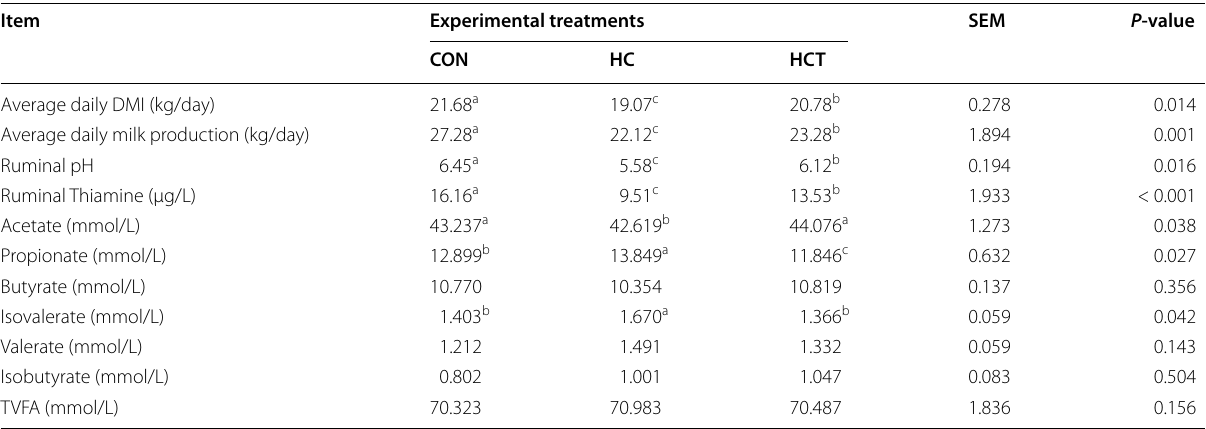
Table 1 Effects of high-concentrate diet feeding and thiamine supplementation on average dry matter intake (DMI), milk production, ruminal pH, ruminal thiamine content and ruminal VFAs content